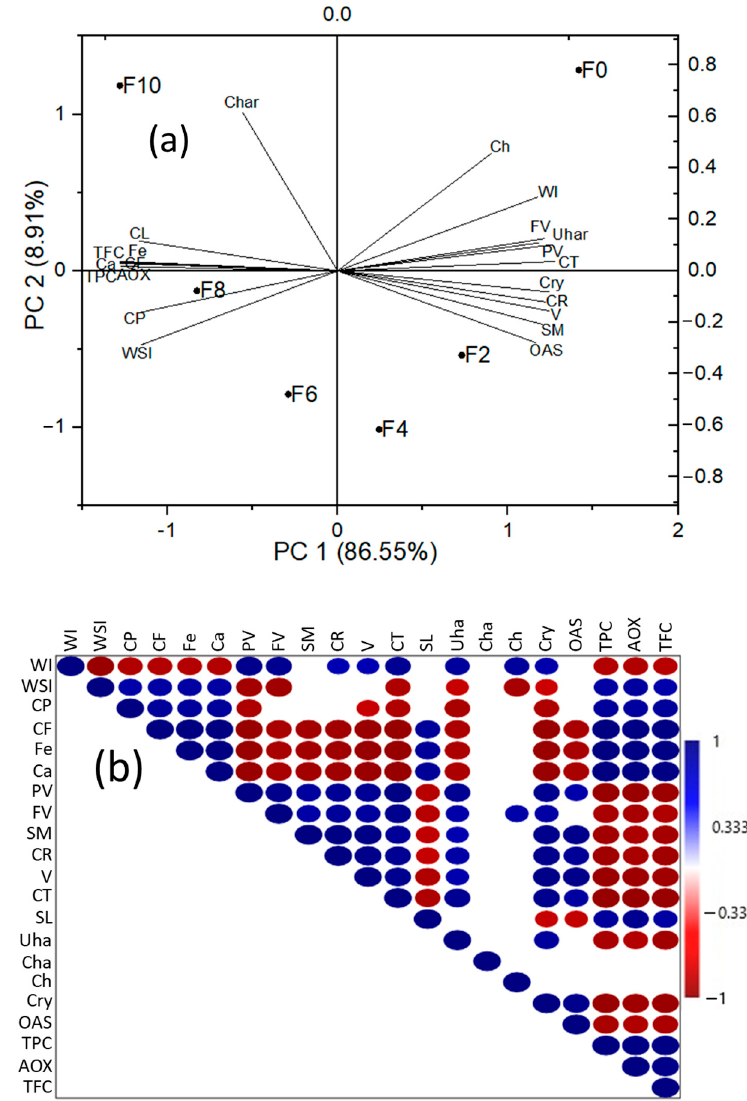
Figure 9. Correlation analysis: ( a ) biplot of PCA of FRNs and ( b ) Pearson correlation analysis. WI represents whiteness index, WSI represents water solubility index, CP represents crude protein, CF represents crude fiber, Fe represents iron, Ca represents calcium, PV represents peak viscosity, FV represents final viscosity, SM represents storage modulus at 43.7 rad/s, CR represents creep at 274.211 s, V represents viscosity at 0.398 s − 1 , CT represents cooking time, SL represents solid loss, Uha represents uncooked noodle hardness, Cha represents cooked noodle hardness, Ch represents chewiness of cooked noodles, Cry represents crystallinity %, OAS represents overall acceptability of noodles, TPC represents total phenolic content, AOX represents antioxidant capacity, and TFC represents total flavonoid content. The colored ellipse in the upper triangle showed the correlation significance at p < 0.05. The blue color shows a positive correlation, and the maroon color shows a negative correlation. F0 represents 0% MLP, F2 represents 2% MLP, F4 represents 4% MLP, F6 represents 6% MLP, F8 represents 8% MLP, and F10 represents 10% MLP.